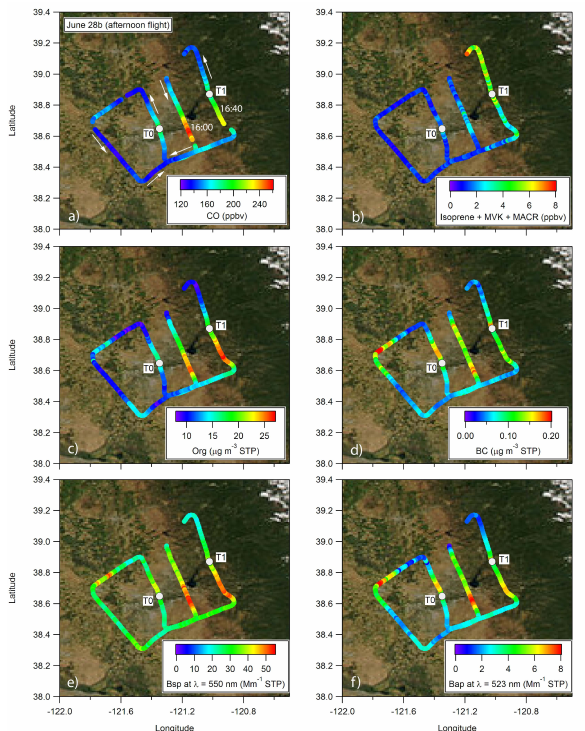
Fig. 23. Semi-Lagrangian G-1 flight tracks on the afternoon of 28 June, with the points color coded by: (a) CO, (b) sum of isoprene, methyl vinyl ketone (MVK), and methacrolein (MACR), (c) organic aerosol mass concentration, (d) BC mass concentration, (e) Neph- elometer scattering coefficient at λ = 550nm, and (f) PSAP absorp- tion coefficient at λ = 523nm.